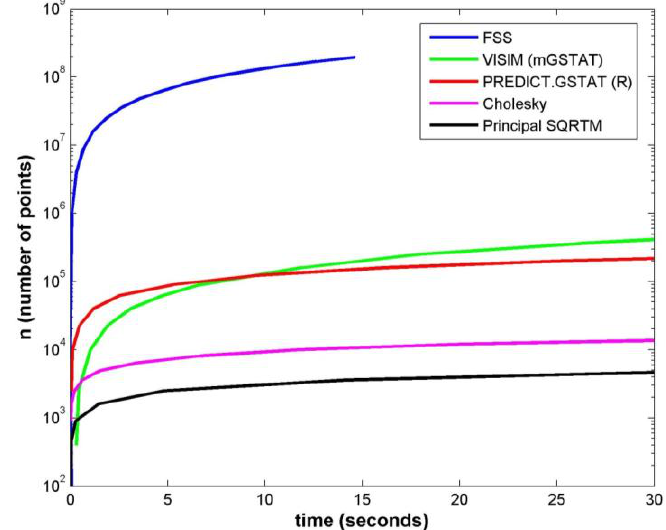
Figure 12. Time comparison among methods for unconditional simulation of a scalar random